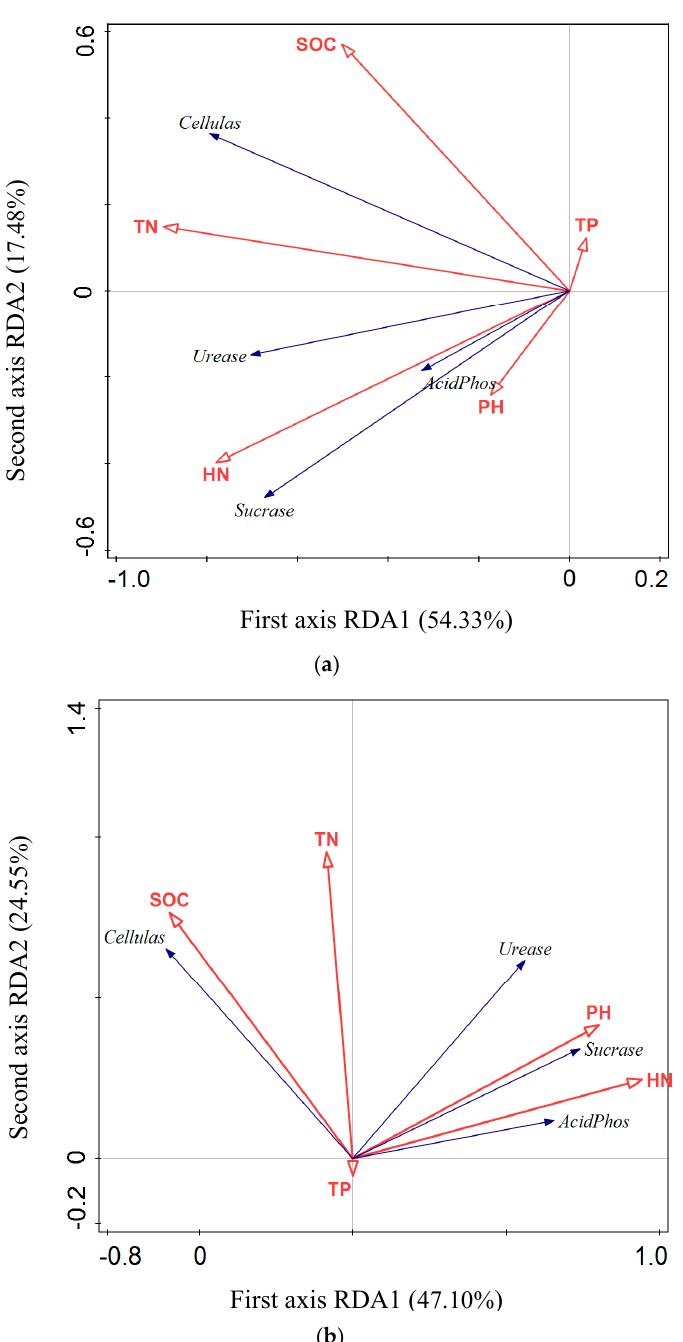
First axis RDA1 ( 47.10% ) Figure 3. ( a ) RDA analysis of soil enzyme activities and environmental factors in the evergreen broad-leaved forest. ( b ) RDA analysis of soil enzyme activities and environmental factors in the coniferous and broad-leaved mixed forest (pH: soil pH, SOC: soil organic carbon content, TN: soil total nitrogen content, TP: soil total phosphorus content, NH: soil hydrolyzed nitrogen content). In the coniferous and broadleaf mixed forest, the first sequence axis and the second sequence axis explained 47% and 25% of the variability, respectively, and their cumulative explanatory power was 72%, which was statistically significant. The hydrolyzed nitrogen content, soil pH, soil organic carbon content, and total nitrogen content all had significant effects on soil enzyme activity ( p < 0.01), explaining 43%, 35%, 31%, and 23% of the varia- tion, respectively. Sucrase activity was strongly correlated with pH and HN. Cellulase activity was strongly correlated with SOC. Urease activity was strongly correlated with pH and HN. Acid phosphatase activity was strongly correlated with HN and pH. 4. Discussion 4.1. Variation Characteristics of Soil Enzyme Activity Sucrose is catalyzed by the enzyme sucrase. Hydrolyzed to glucose and D-D-fruc- tose, two kinds of reducing sugar, the hydrolysis of cellulose to glucose monomers process is, in the cellulose enzyme, a complex enzyme system under the action of different en- zymes; urease can in enzymatic soil urea hydrolyze into ammonia, the soil phosphatase is a kind of catalytic organophosphorus compound ore, which leads to an inorganic phos- phorus enzyme. Therefore, we measured soil cellulase, sucrase, urease ,and acid phospha- tase, respectively, to reflect the conversion or recycling efficiency of soil main nutrient elements C, N, and P. Sucrase activity was higher in the pH 4.0 and pH 3.25 acid rain treatments than the other acid rain treatments in the early and middle stages of the experiment, but its activity decreased with increasing acid rain concentration in the later stage. This indicated that sucrase activity is promoted by acid rain in the short term but inhibited in the long term under the lower-concentration acid rain treatment, while it is continuously inhibited un- der higher-concentration acid rain treatments. This was consistent with the observations of Wang et al. on sucrase activity in acidic red soil [38]. Long-term acid deposition inhibits the enzymatic activity of organic carbon decomposition [39,40]. Furthermore, the increase